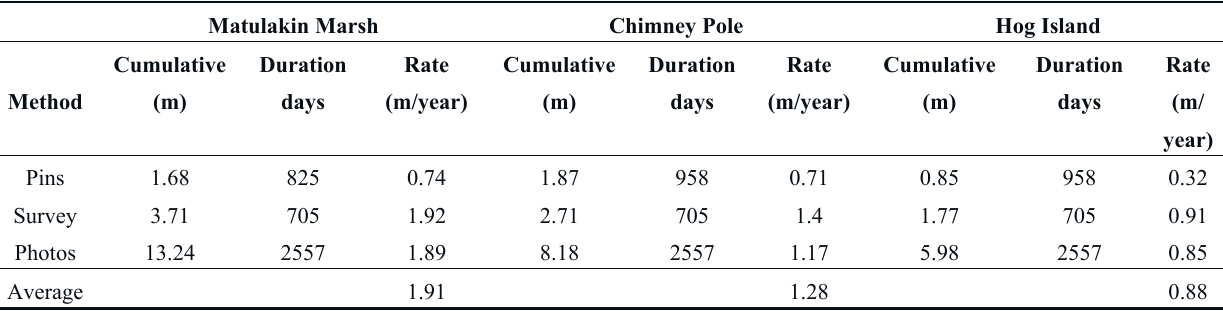
Figure 7. Frequency magnitude distribution of erosion events for the three sites where field measurements where collected. Matulakin Marsh (MM); Chimney Pole (CP); Hog Island (HI). Table 1. Erosion at the three study sites estimated from each method (erosion pins, total station surveys, historical imagery). Average of survey and imagery methods is given as a best estimate since erosion pins may underestimate